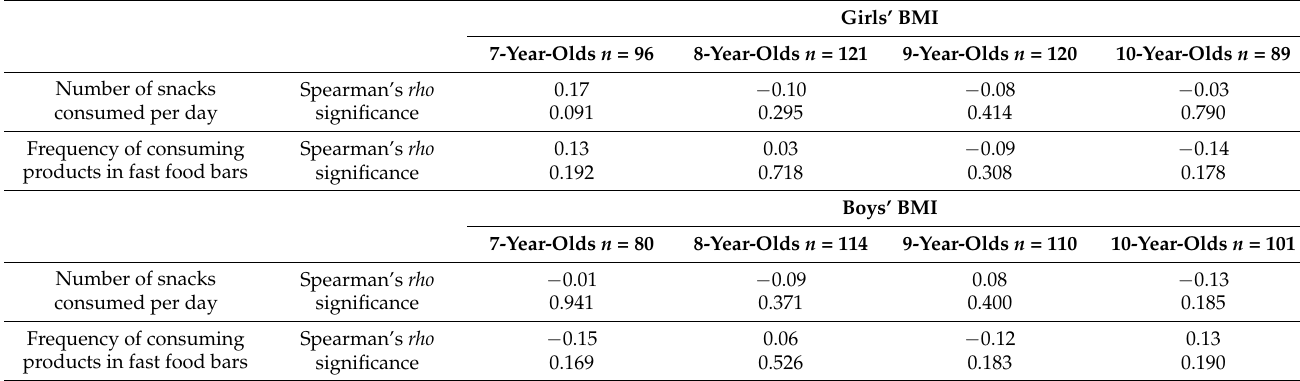
Table 6. The correlation between the number of snacks consumed per day and the frequency of consumption in fast food bars with children’s BMI according to age and